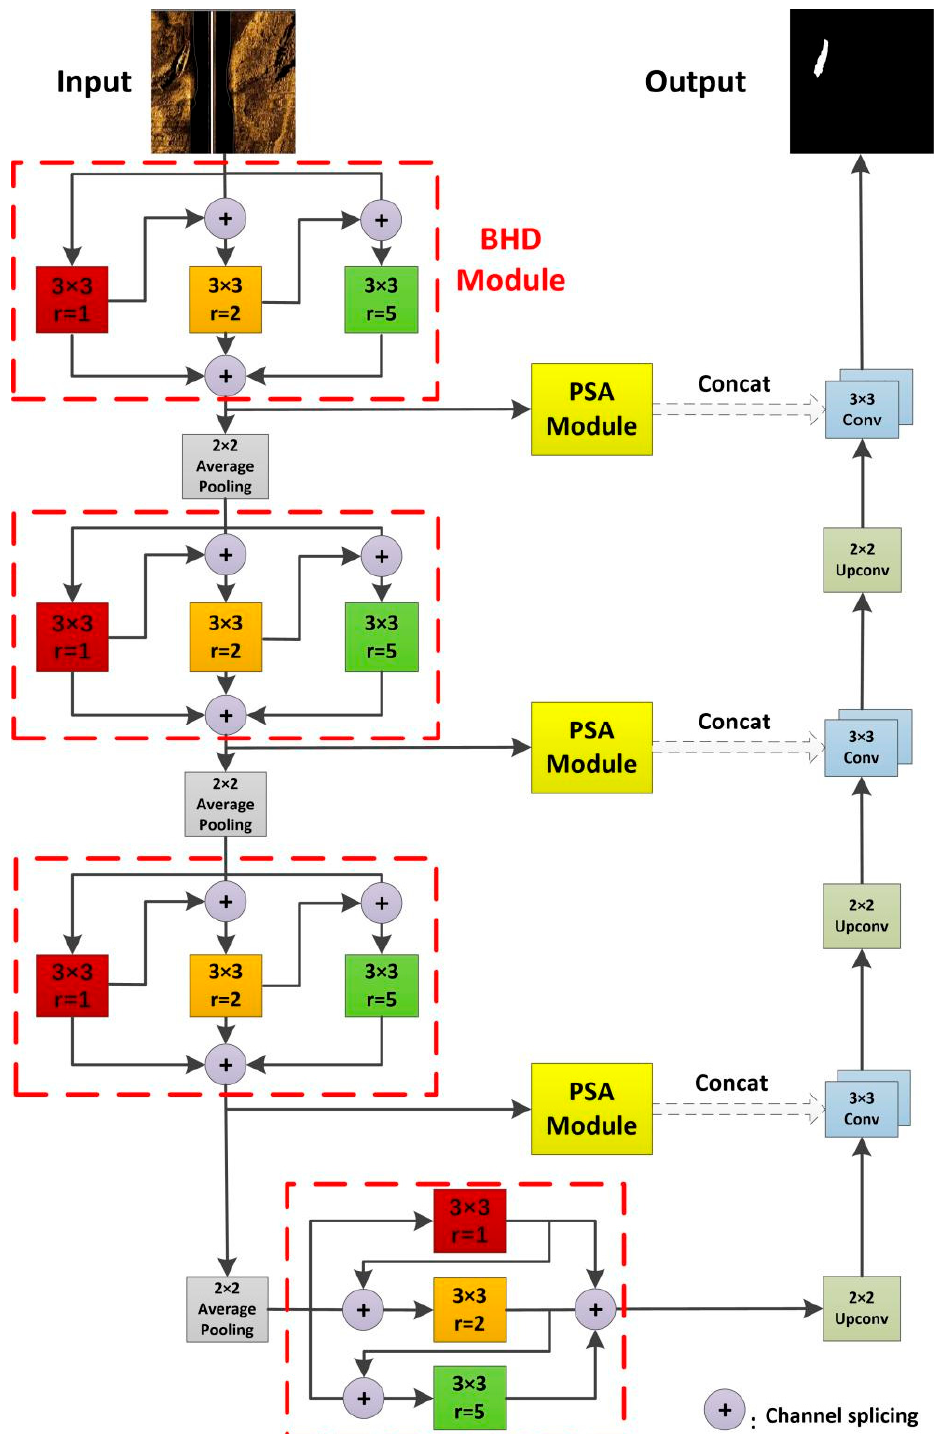
Figure 7. Structure of the BHP-UNet model.